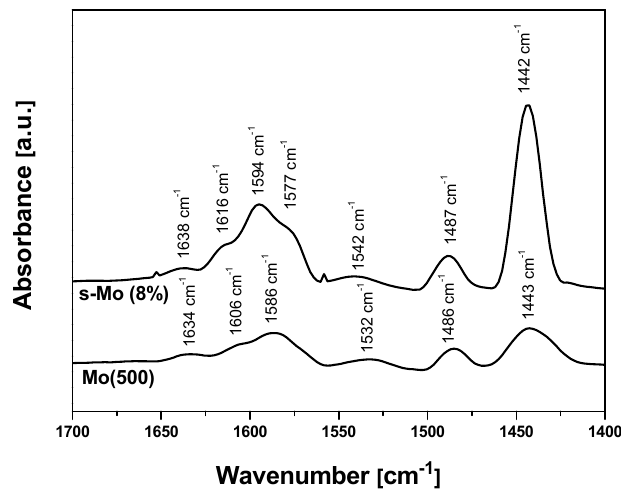
Figure 4. FTIR spectra of adsorbed pyridine on Mo (500) and s-Mo (8) catalysts.